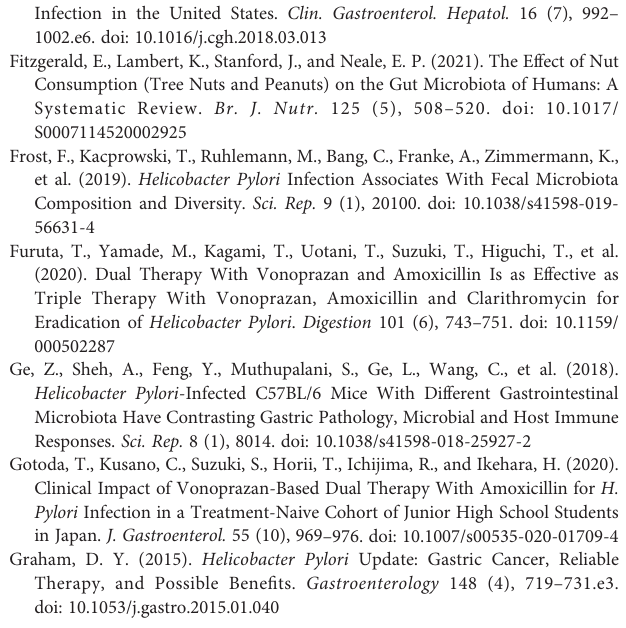
Supplementary Figure 1 | KEGG pathway analysis of L-VA and H-LA therapy. Signi fi cant signaling pathways enriched by comparing L-1 and L-2 (A) , L-2 and L-3 (B) , L-1 and L-3 (C) , H-1 and H-2 (D) , H-2 and H-3 (E) , H-1 and H-3 (F) according to KEGG pathway analysis. L-1: before eradication in the L-VA group; L-2: after eradication in the L-VA group; L-3: con fi rmation in the L-VA group; H-1: before eradication in the H-VA group; H-2: after eradication in the H-VA group; H-3: con fi rmation in the H-VA group. Supplementary Figure 2 | Ecological co-occurrence network analysis of L-VA and H-LA therapies. The network analysis before eradication ( A for L-VA therapy and D for H-VA therapy), after eradication ( B for L-VA therapy and E for H-VA therapy) and con fi rmation ( C for L-VA therapy and F for H-VA therapy). L-VA: Dual therapy consisting of a low dose of amoxicillin (1000 mg b.i.d.) and VPZ (20 mg b.i.d.); H-VA: dual therapy consisting of a high dose of amoxicillin (1000 mg t.i.d.) and VPZ (20 mg b.i.d.). Supplementary Figure 3 | SCFAs analysis of L-VA therapy. The quanti fi cation of propionic acid (A) , butyric acid (B) , isobutyric acid (C) , isovaleric acid (D) , valeric acid (E) , and hexanoic acid (F) at the three time points of L-VA therapy. L-1: before eradication in the L-VA group; L-2: after eradication in the L-VA group; L-3: con fi rmation in the L-VA group. Supplementary Figure 4 | SCFAs analysis of H-VA therapy. The quanti fi cation of butyric acid (A) , isobutyric acid (B) , isovaleric acid (C) , and hexanoic acid (D) at the three time points of H-VA therapy. H-1: before eradication in the H-VA group; H-2: after eradication in the H-VA group; H-3: con fi rmation in the H-VA